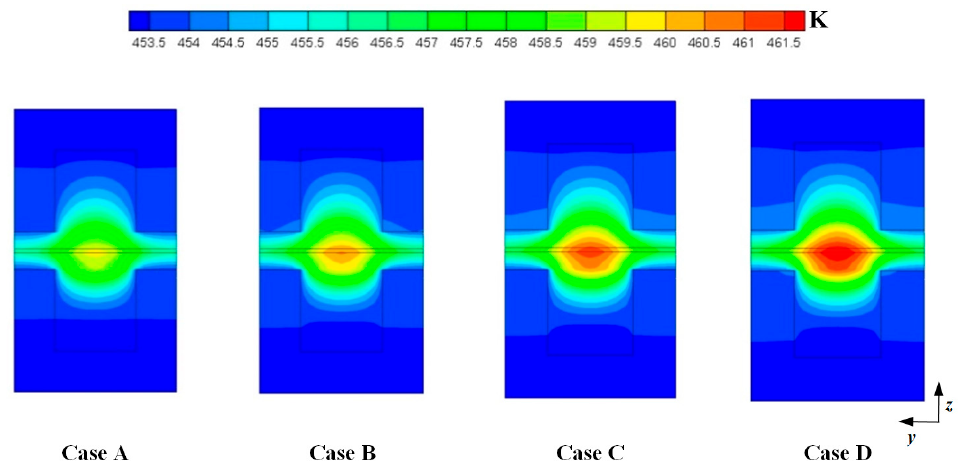
Figure 4. Temperature distributions at the middle plane of fuel cells (Case A: DL = 5; Case B: DL = 7; Case C: DL = 9; Case D: DL = 11).